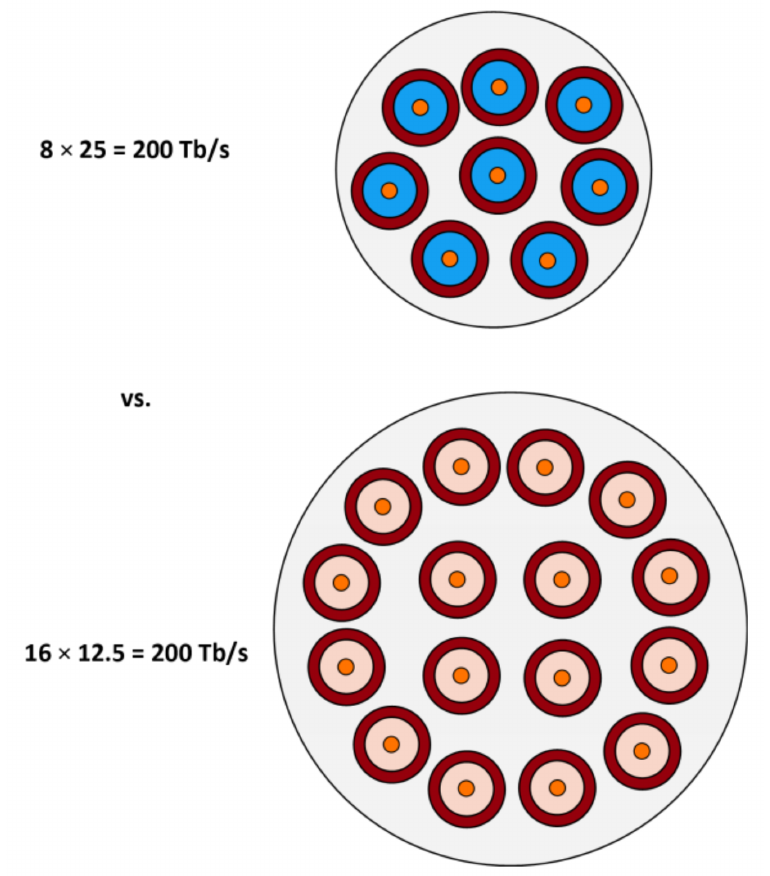
Figure 12. Traditional vs. SDM cable